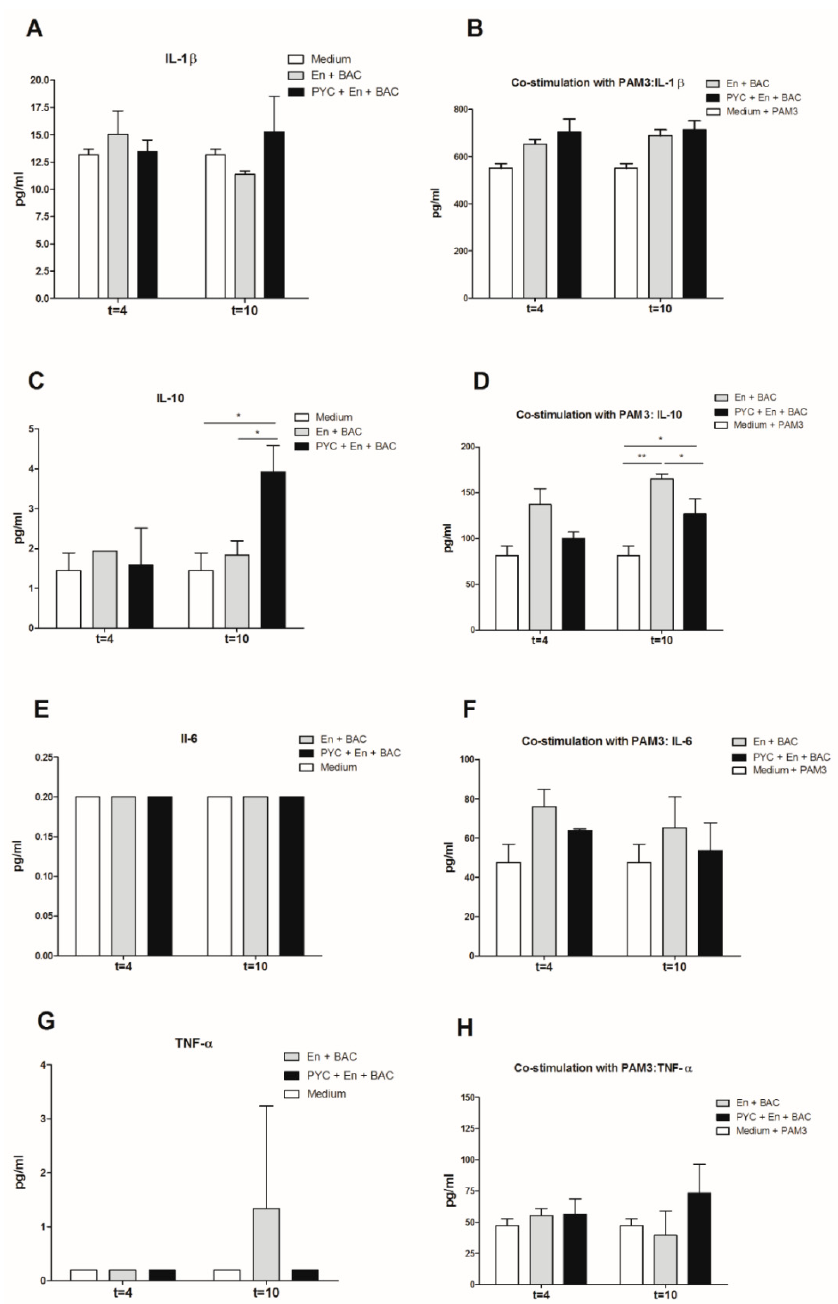
Figure 6. Proinflammatory activity of PYC is abolished by metabolism in the presence of human faecal suspension. THP-1 macrophages were incubated 18 h with dialysates collected after 4 h and 10 h of metabolism with ( A , C , E , G )) and without ( B , D , F , H )) co-stimulation with the known ligand PAM3 at a concentration of 0.1 µ g/mL. After 24 h of incubation the concentration of ( A , B ) IL-1 β , ( C , D ) IL-10, ( E , F ) IL-6 (below detection limit on figure ( E )), and ( G , H ) TNF- α in the supernatants was determined. PYC samples were metabolized in the presence of E: enzymes; BAC: intestinal bacteria (human faecal suspension). All data are expressed as the mean ± SD of n = 4 independent replicates. p -values < 0.05 are considered statistically significant, as analyzed with one-way ANOVA with Tukey post hoc comparison test (GraphPad Prism). Significant differences are indicated by asterisks: * p < 0.05; ** p < 0.01.